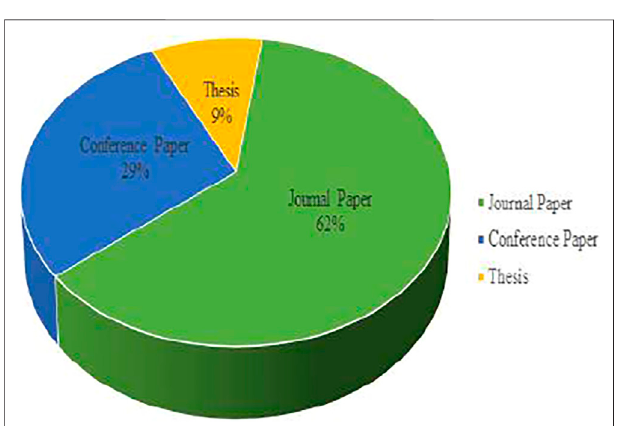
FIGURE 3 | Primary studies according to the publication